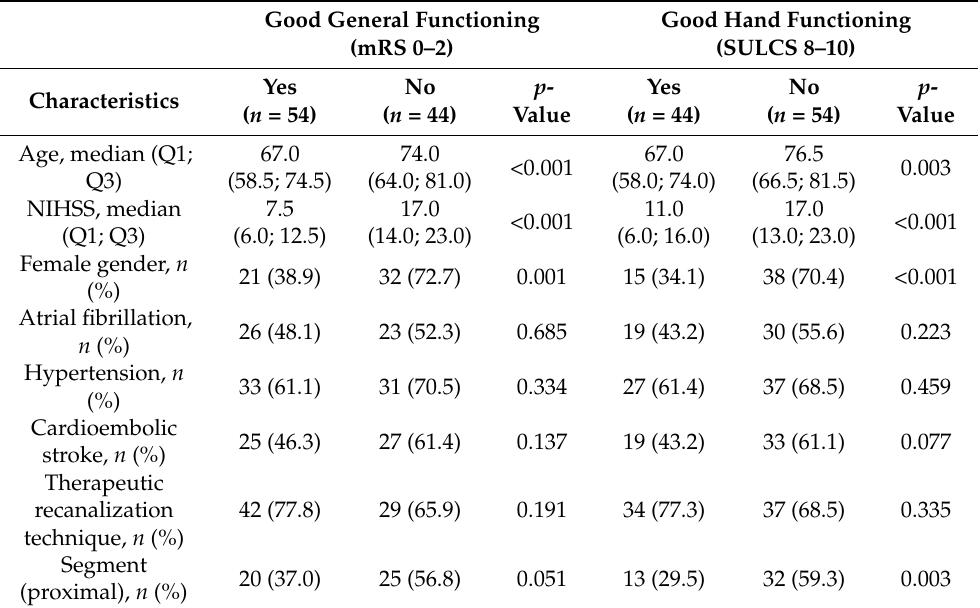
Table 2. Patient functioning 12 weeks after stroke for the overall population, according to patients’ clinical characteristics.